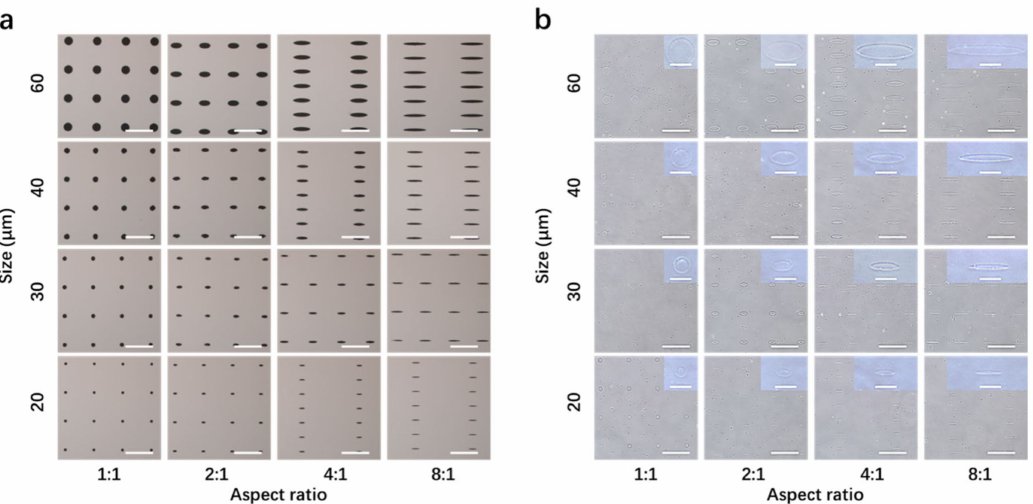
Figure 1. ( a ) Phase-contrast micrographs ofthe photomasks. Scale bar = 200 µ m. ( b ) Phase-contrast micrographs of the micropatterned surfaces. The inserts are high-magnification photomicrographs of the micropatterns. Scale bars of the low- and high-magnification photomicrographs are 200 and 50 µ m, respectively.